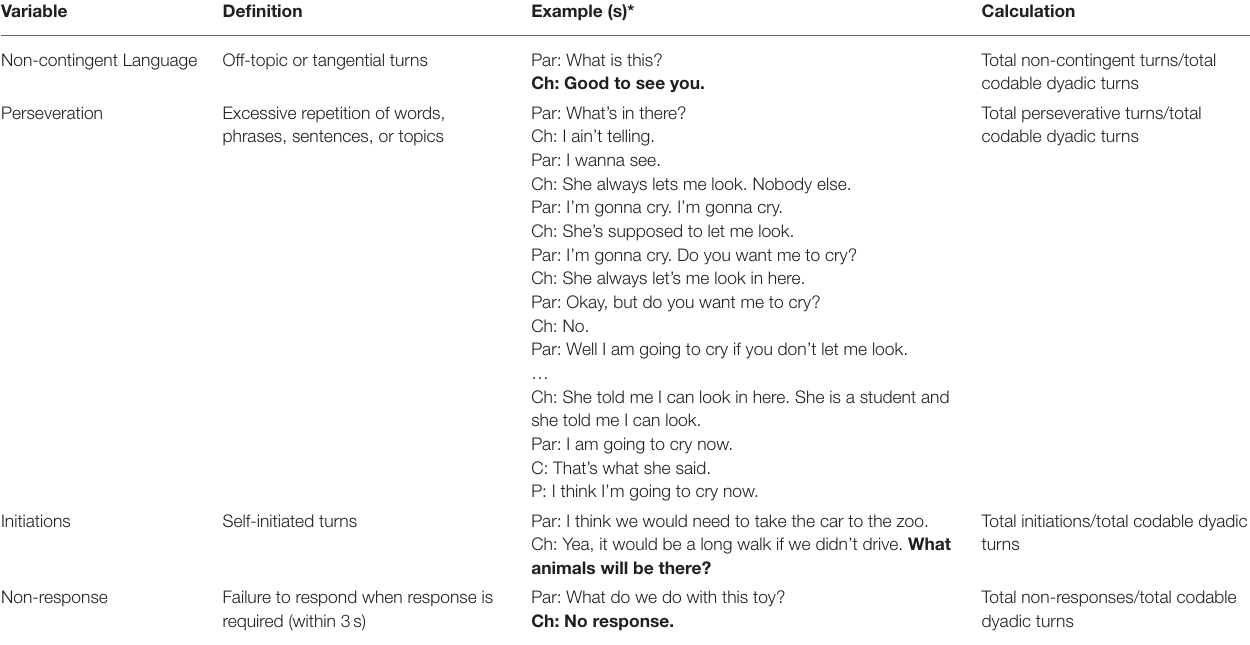
TABLE 2 | Pragmatic coding